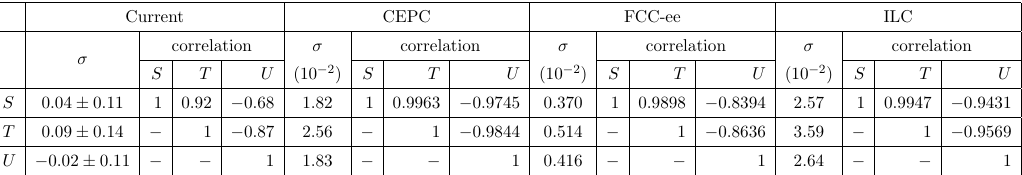
Table 2 . Estimated S , T , and U ranges and correlation matrices (cid:26) ij from Z -pole precision mea- surements of the current results [37], mostly from LEP-I [34], and at future lepton colliders at table 1. Gfitter package [36] is used in obtaining those